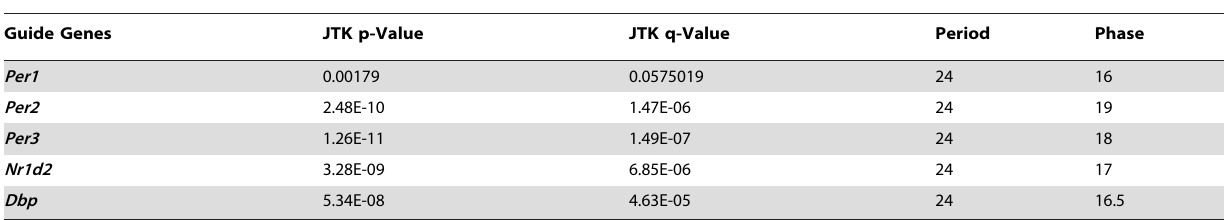
Table 1. Reference Genes.